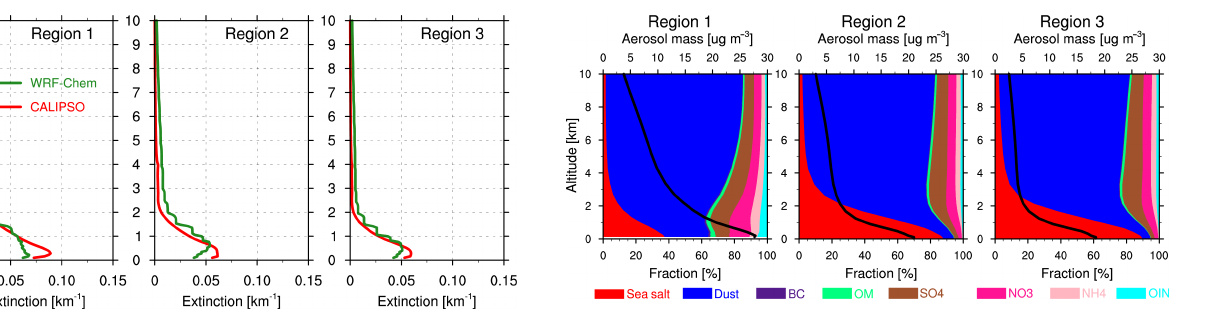
Figure 11. Vertical distributions of annual mean extinction from the CALIPSO retrieval and the corresponding WRF-Chem simula- tion averaged for the period 2010–2014 over the three sub-regions shown in Fig. 4.